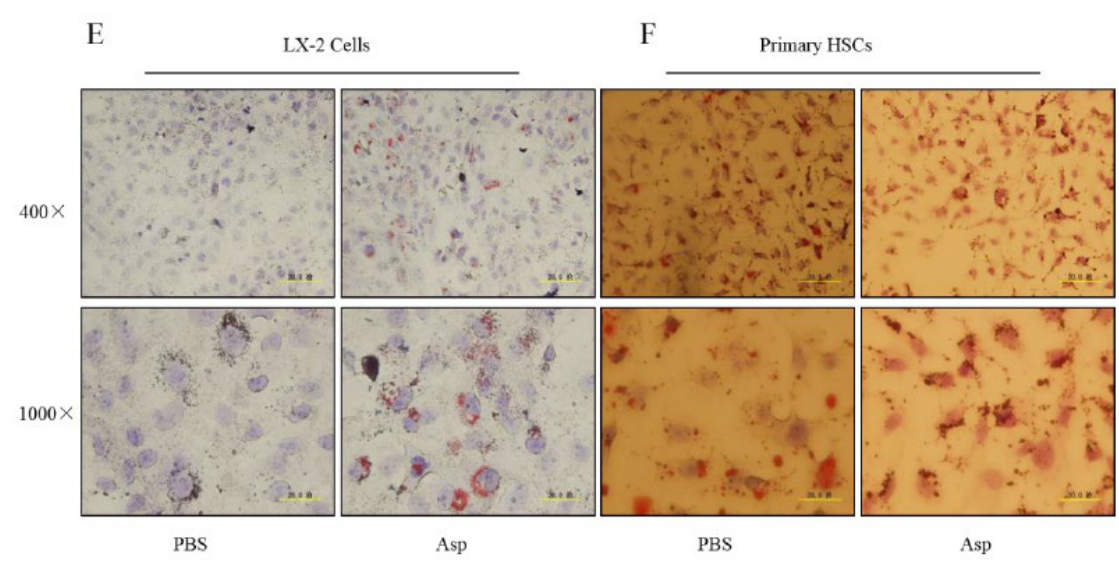
Figure 7. Asp supplementation suppressed HSC proliferation and activation and promoted apoptosis in vitro. ( A , B ) The proliferation ability of the cells were measured with CCK8 kit in LX-2 cells and primary HSCs. ( C , D ) The apoptosis rates of the cells were measured using Annexin V-FITC/7-AAD by flow cytometry. ( E , F ) Fat droplets in the LX-2 cells were detected by Oil Red O staining. (n = 3). The results shown are mean ± standard error. * p < 0.05, ** p < 0.01, *** p < 0.001.